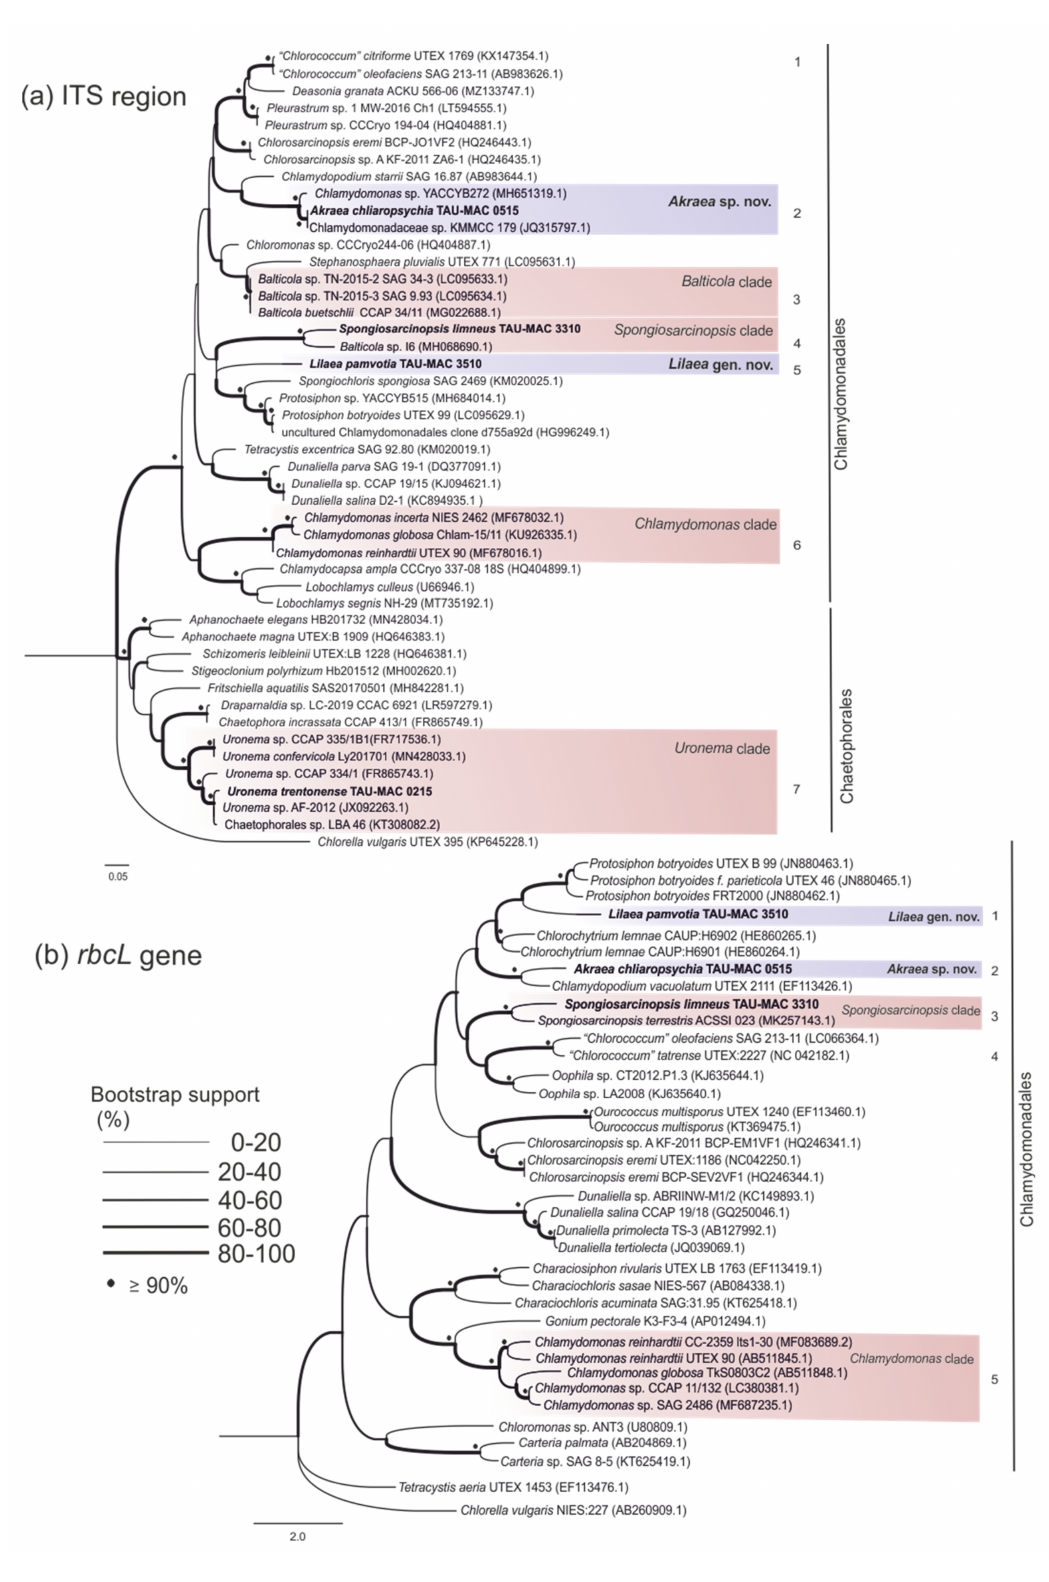
Figure 4. Phylogenetic relationships of the Chlamydomonadales TAU-MAC strains based on ( a ) ITS region (c. 500bp) and ( b ) rbcL gene (c. 1050bp) genes. Line thickness at branches (see explanation in figure) represents bootstrap support values (bootstrap support for ML and MP analysis). The numbers in parentheses are GenBank accession